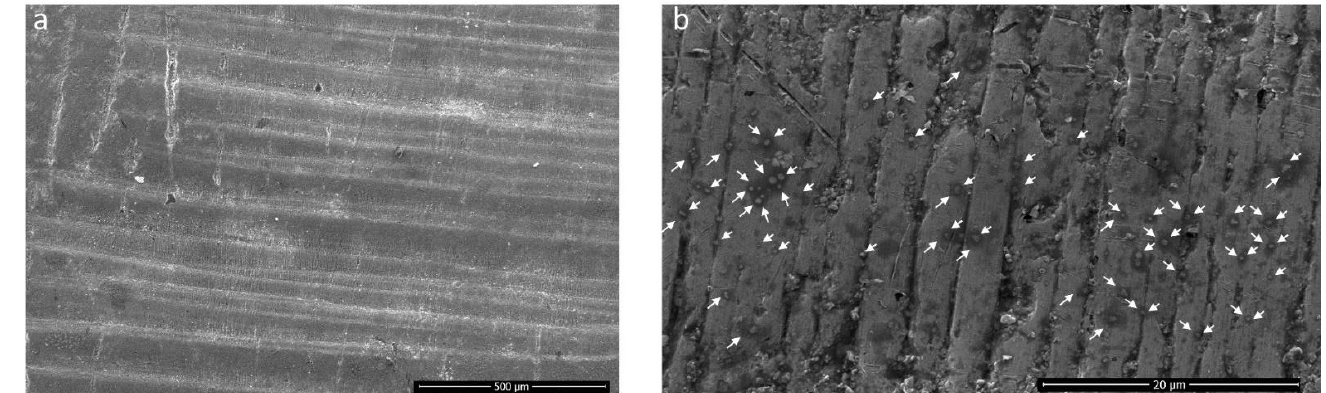
Figure 9. ( a ) Improved surface morphology with crack pinning effect of Al 2 O 3 wt % 99.5, SiC wt % 0.5 at 120 W laser power. ( b ) Pinning effect of SiC can be seen clearly in magnified micrograph of the same sample in ( a ).